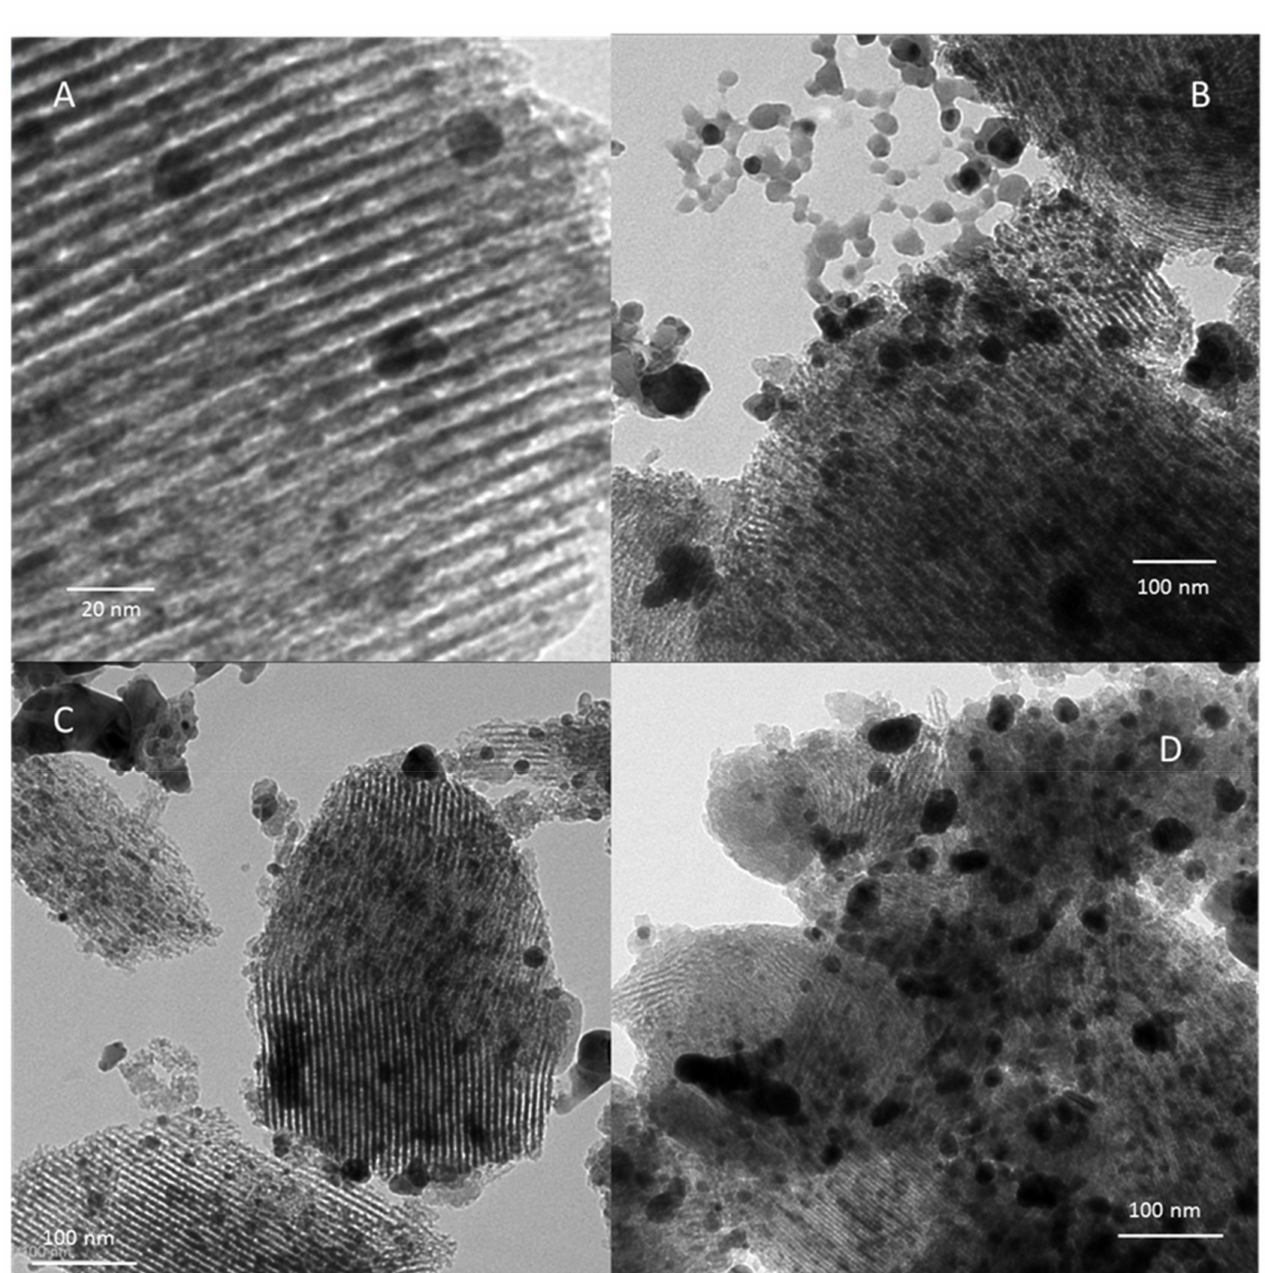
Figure 8. TEM micrographs of the calcined 15.5 Ag/SBA-15-calc material after I 2 adsorption test. Images ( A – D ) represent different views of SBA-15 channels and the presence of AgI crystalline phases inside or outside of the